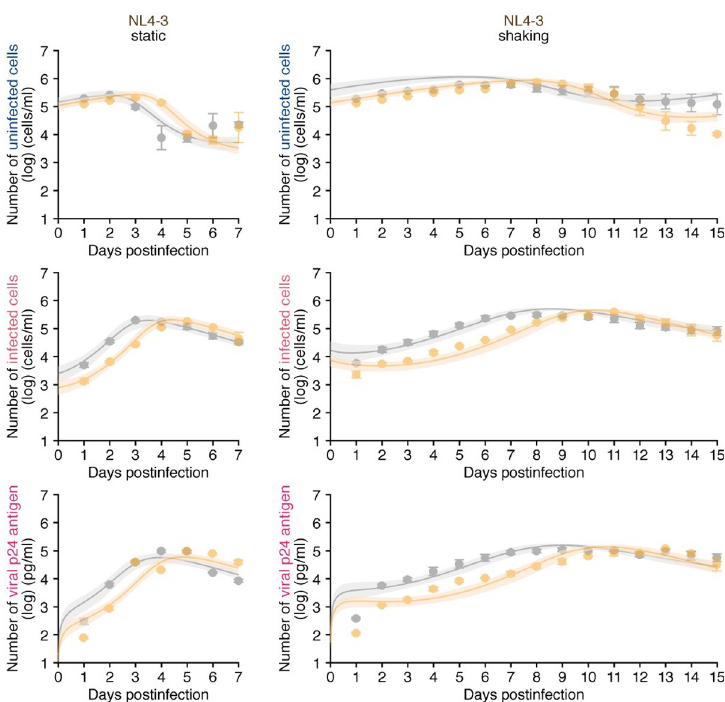
Fig 2. Dynamics of HIV-1 NL4-3 infection through cell-to-cell and cell-free infection without or with IFN- α . Jurkat cells were infected with HIV-1 strain NL4-3 at MOI 0.1 in the static and shaking culture under treated with IFN- α or untreated. Time-course experimental data and the fitting of Model 1 (see Methods). The time-course of experimental data for the numbers of uninfected cells (top) and infected cells (middle), and the amount of viral p24 antigen in the culture supernatant (bottom) in the static culture (left) and shaking culture (right) are shown. Gray and orange curves respectively indicate the results in the absence or presence of IFN- α treatment, respectively. The dots with error bars are the averages and SEMs of three independent experiments. The shadow regions correspond to 95% posterior predictive intervals, and the curves give the best-fit solution Model 1 to the experimental dataset.